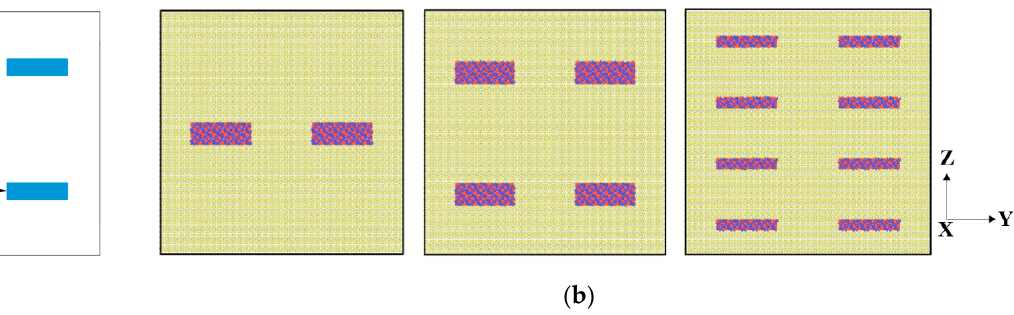
Figure 8. The cross sections of systems. ( a ) Schematic diagrams; ( b ) The systems with 2, 4, and 8 precipitates. Stress vs. strain and the surface fraction vs. strain relationships of the single-crystal